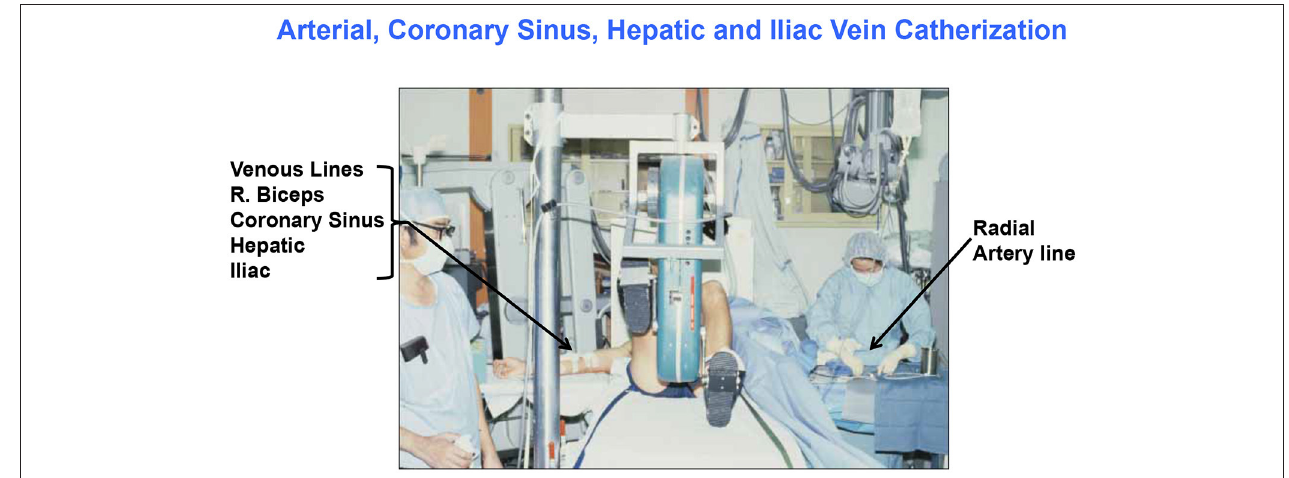
FIGURE 1 | Illustration of the invasive and complicated methods to simultaneously determine cardiac and whole-body energy substrate partitioning in man. Setting for ( 26, 28, 29, 45–47); G. A. B. personal photo.